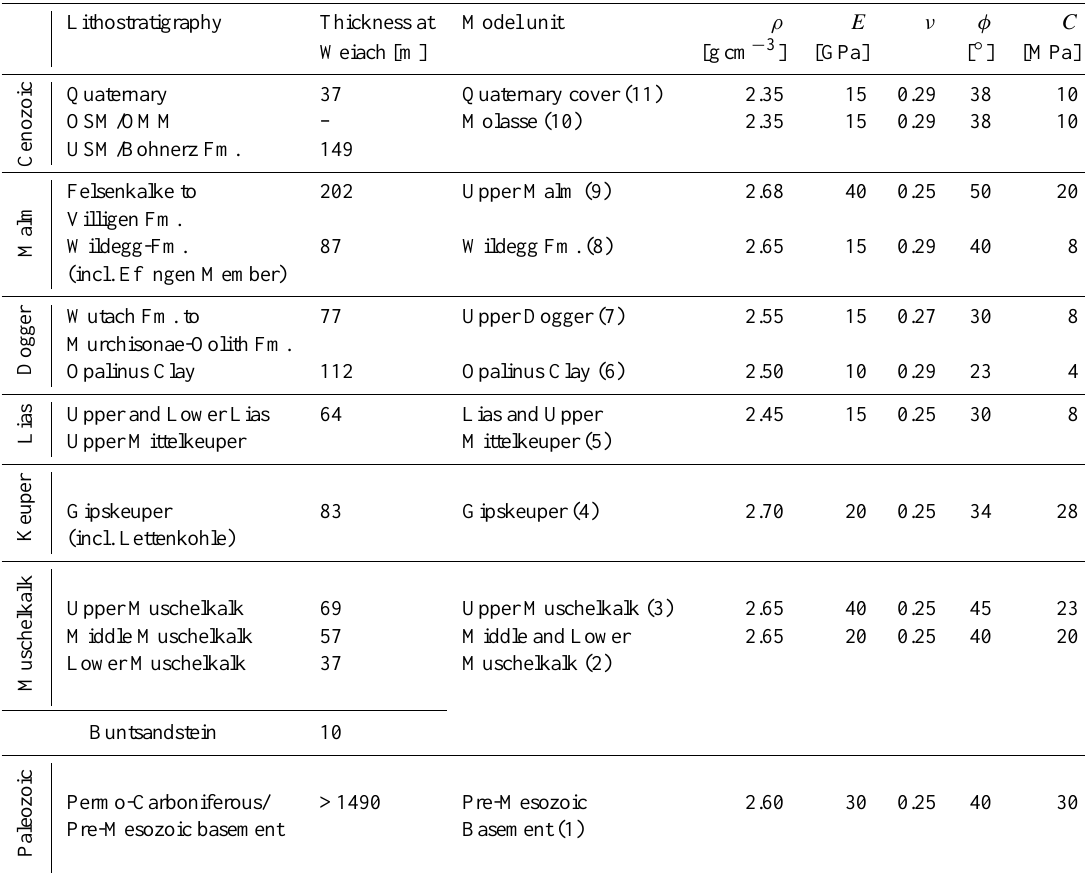
Table 1. Lithological and grouped geomechanical units with mechanical properties. Estimation of density values ( ρ ) are based on Matter et al. (1988), elastic properties (Young’s Modulus E and Poisson’s ratio ν ) are based on Nagra (2001) and Mohr–Coulomb strength parameters (friction angle φ and Cohesion C ) are estimated from Böhringer et al. (1990) and Nagra